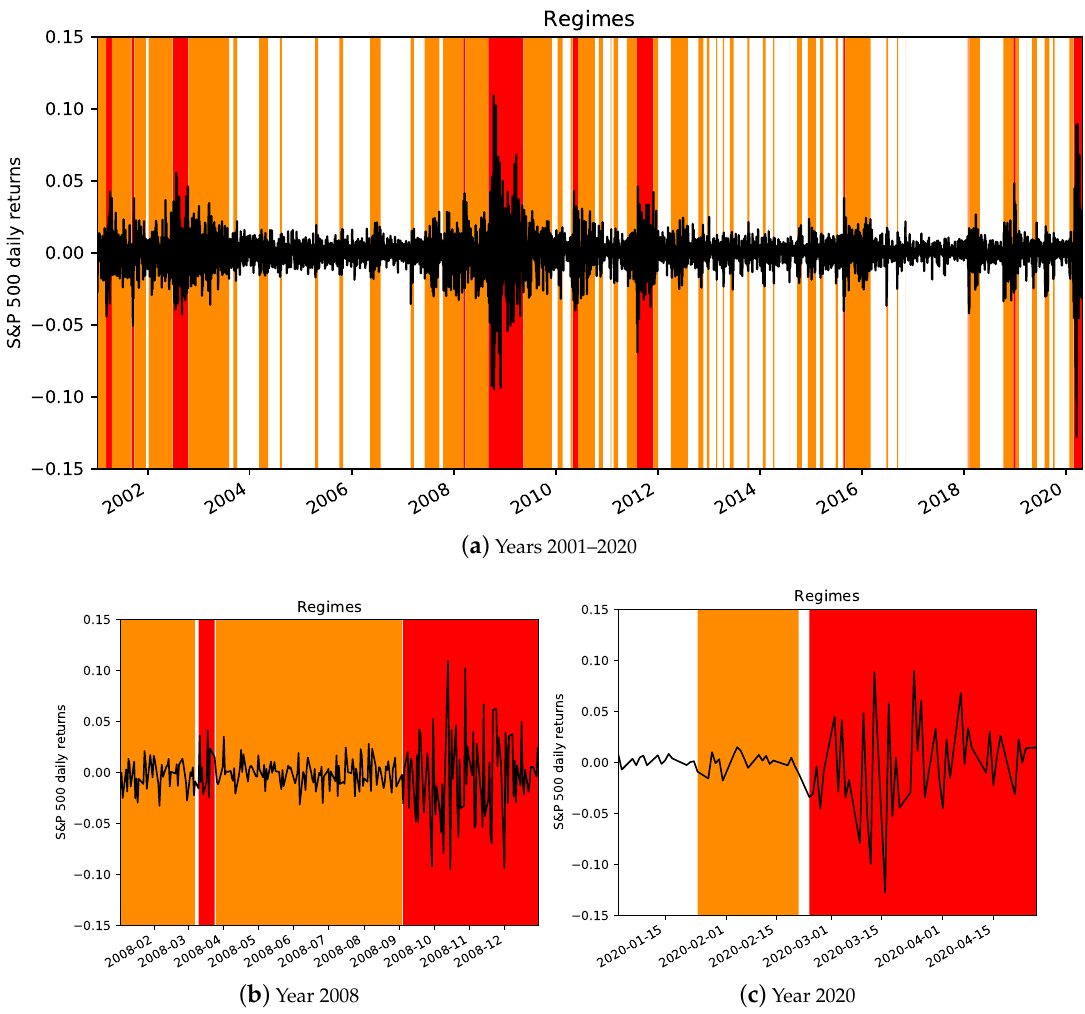
Figure 1. Time-series plots for the S&P 500 returns and different regimes based on smoothed probabilities for the periods: 2001–2020 (Panel a ), 2008 (Panel b ), and 2020 (Panel c ). In all panels, the white, orange, and red colors identify the tranquil, volatile, and turbulent regimes,